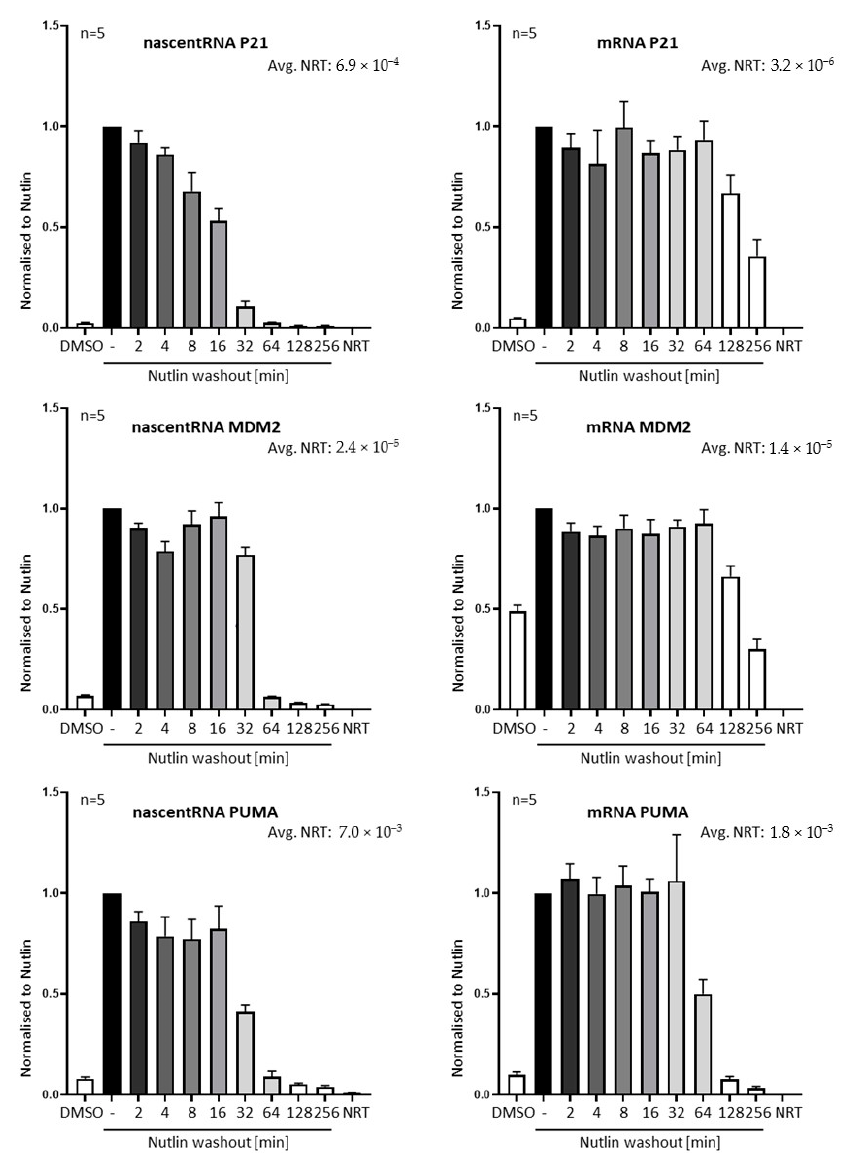
Figure 2. Rapid reduction in transcription from p53-responsive genes upon Nutlin removal. SJSA cells were treated with Nutlin, followed by wash-out for the indicated periods. RNA was isolated and analyzed by reverse transcription and qPCR. Quantification of non-processed pre-mRNA (nascent RNA) and processed mRNA of the target genes P21, MDM2 and PUMA reflected the increase in transcriptional activity upon Nutlin treatment and its reduction after Nutlin washout. From five biological replicates, the RNA levels were normalized to the amount of RNA from the housekeeping gene 36B4, followed by normalization to the Nutlin-treated sample before washout, and displayed as mean + SEM. NRT controls reflect the negligeable amount of DNA contamination of all RNA samples. The reduction of RNA synthesis (nascent RNA) was seen within less than one hour after washout. “-“ indicates that Nutlin was not washed out before harvest.